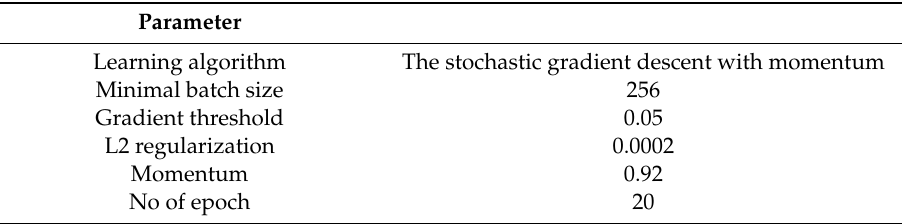
Table 1. The following parameters were used in the U-Net network learning